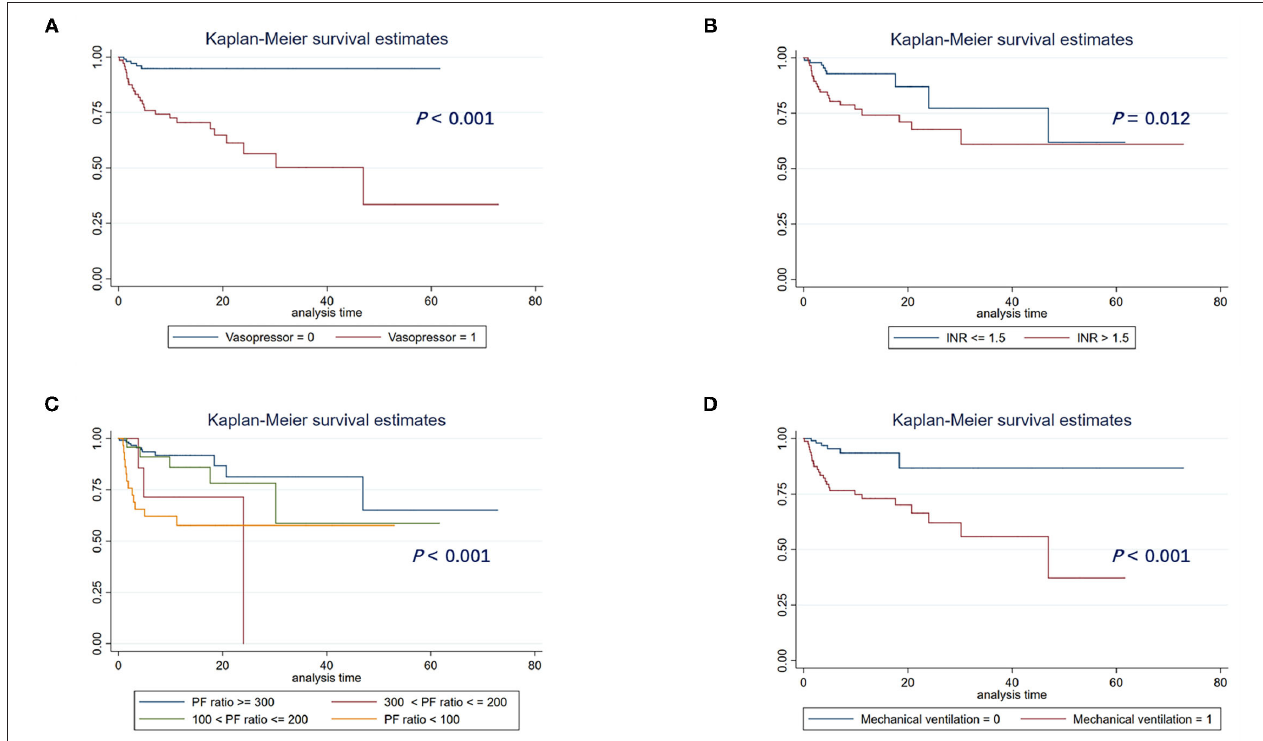
FIGURE 4 | Kaplan-Meier survival curve analysis of hospital mortality in patients stratified by prognostic factors based on Cox-LASSO analysis. (A) With vs. without vasopressor; (B) INF ≤ 1.5 vs. INR > 1.5; (C) PaO 2 /FiO 2 (PF) > 300 mmHg vs. 200 mmHg < PF ≤ 300 mmHg vs. 100 mmHg < PF ≤ 200 mmHg vs. PF ≤ 100 mmHg); (D) with or without mechanical ventilation support. LASSO, least absolute shrinkage and selection operator; INR, international normalized